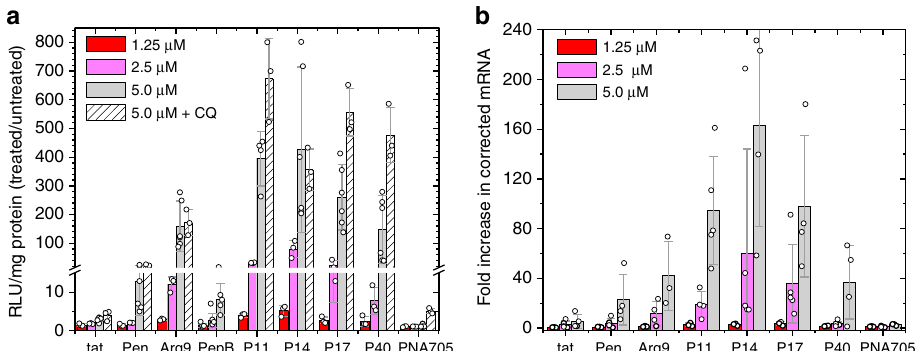
Fig. 2 PDEP-mediated delivery of splice correcting PNA. a Luciferase expression. HeLa pTRE-LucIVS2-705 cells were incubated with varying concentrations of PDEP-705 in serum-free media for 30 min and then incubated for 24 h in complete media. Cell lysates were analyzed for luminescence and standardized by total protein content. The ratios of the RLU μ g − 1 protein for treated samples divided by untreated samples are plotted. To examine the degree of endosomal entrapment, cells were co-incubated with 120 μ M of the endosomolytic agent chloroquine. b mRNA correction. RNA was puri fi ed from lysates of cells treated as above and analyzed by qRT-PCR to determine the fold increase in correctly spliced luciferase mRNA standardized to ACTB1. The relative quanti fi cation of correctly spliced mRNA over untreated cells was calculated using the Pfaf fl model 56 . Error bars are standard deviations of the data, which are shown as open circles, with 3 – 6 data points, from independent experiments, per